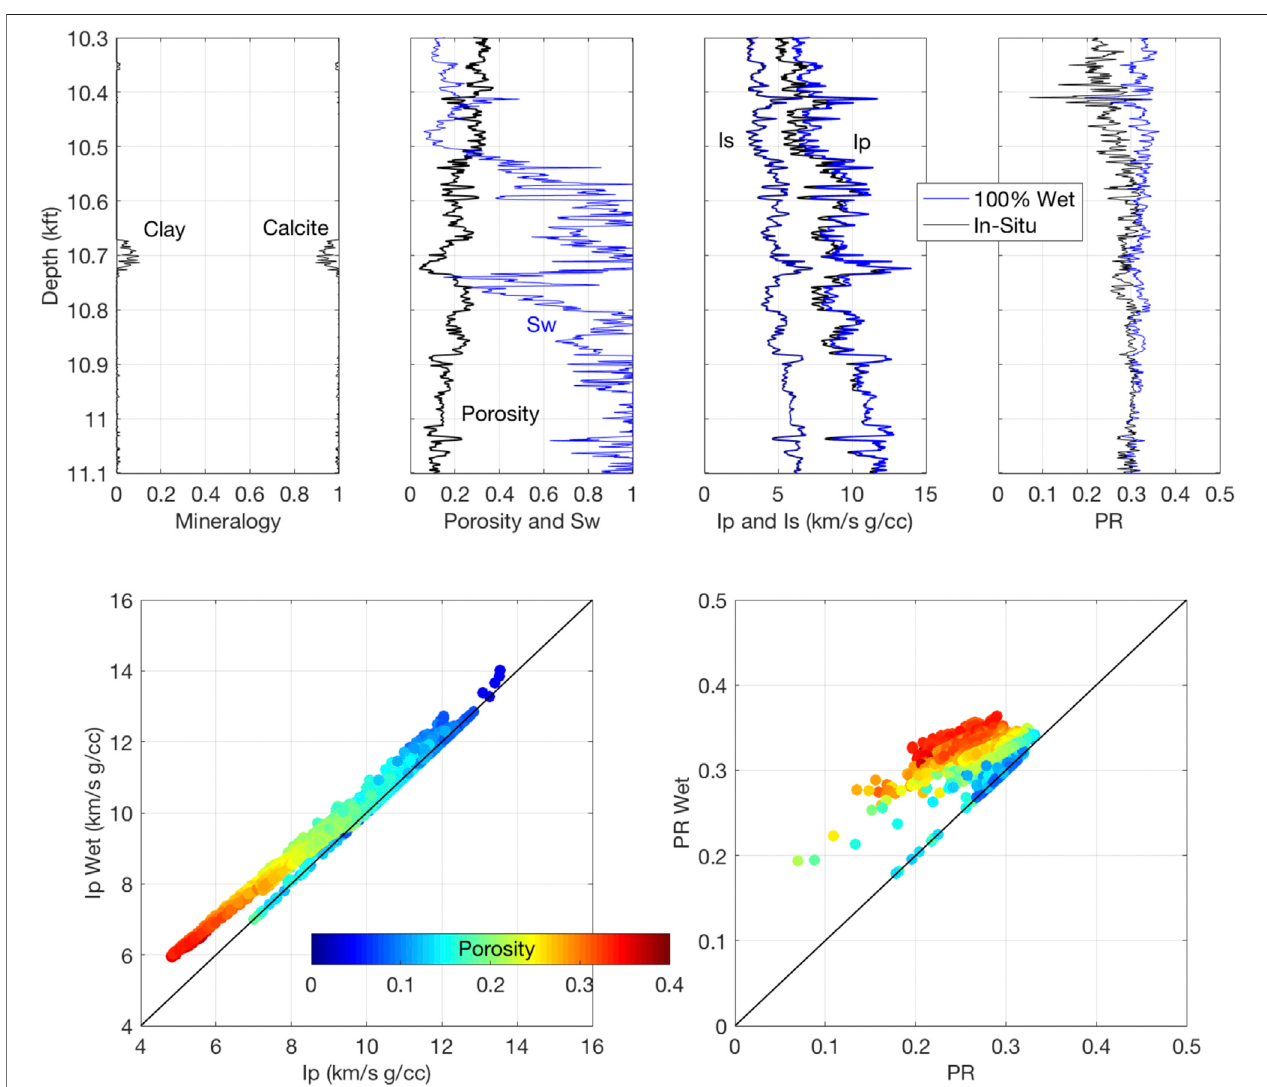
FIGURE 3 | Top: Depth plots for one of the wells from the fi eld under examination. From left to right: Mineralogy; the total porosity and water saturation; P- and S-wave impedances; and Poisson ’ s ratio. In the last two frames, black curves are for measured properties, while blue curves are for these properties at 100% water saturation computed using Gassmann ’ s (1951) fl uid substitution. Bottom: Cross-plots of the in-situ vs. 100% wet P-wave impedance (left) and Poisson ’ s ratio (right) color-coded by the total porosity and using the data shown in top row.